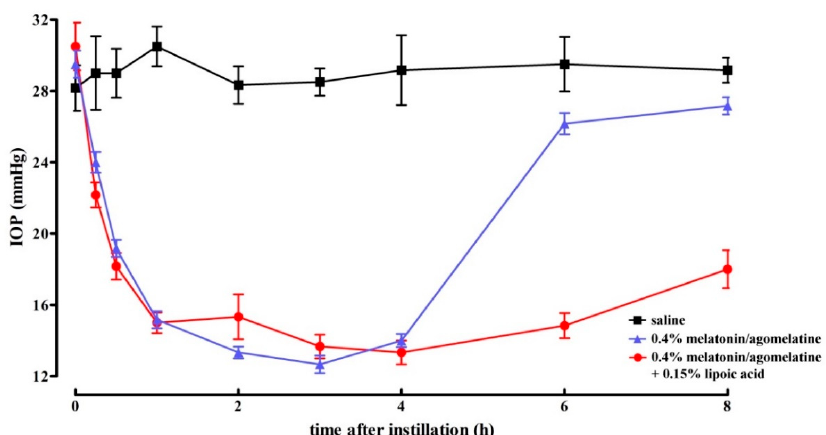
Figure 4. Lowering effect of melatonin and agomelatine at 0.4% without or with lipoic acid formulated in nanomicelles in rats with hypertensive intraocular pressure. No difference in the magnitude of lowering effect could be assessed after the addition of lipoic acid that, however, increased the duration of the mixture efficacy. Data represent the mean ± SEM of data from 3 rats (6 eyes).